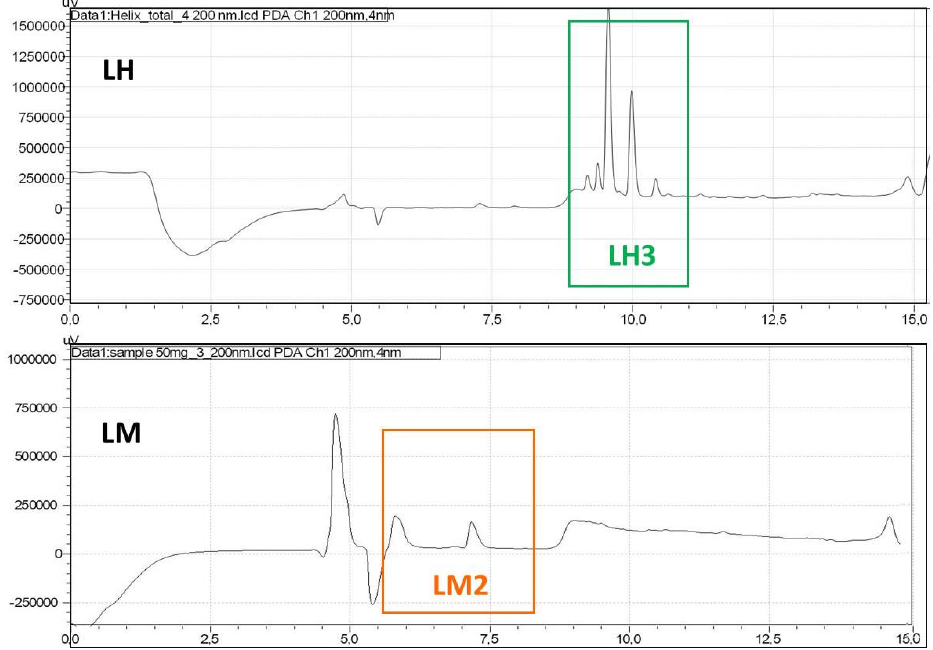
Figure 2. ( Top ) HPLC chromatograms of lyophilized extracts of H. aspersa (LH) and ( Bottom ) mucus of H. aspersa (LM) solubilized in 0.1% TFA (trifluoroacetic acid) and obtained at 200 nm. All extracts (LH, LH3, LM, and LM2) were concentrated and tested for angiogenesis in zebrafish during embryonic